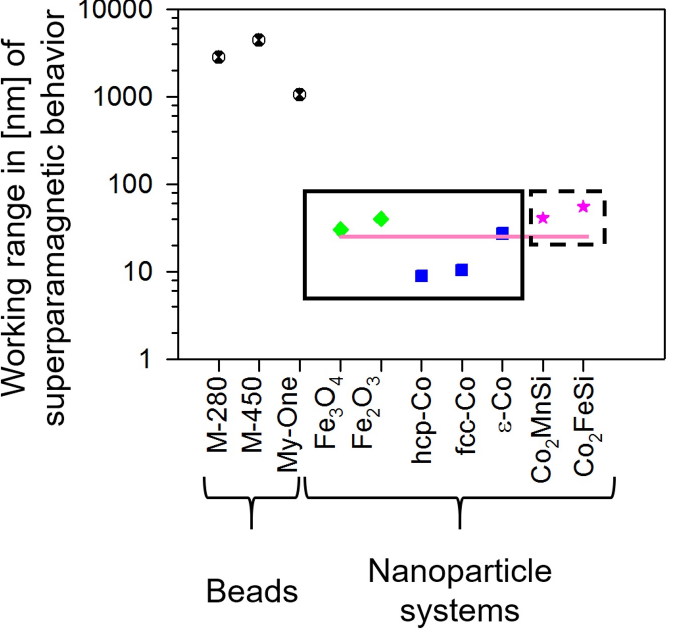
Figure 6. Comparison of the working range of possible superparamagnetic phases to serve as nanoparticles for labelling and separation of